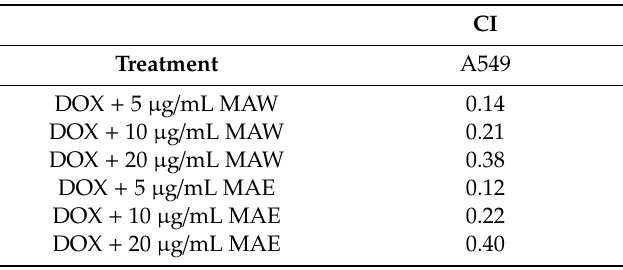
Table 2. Isobolographic analysis.